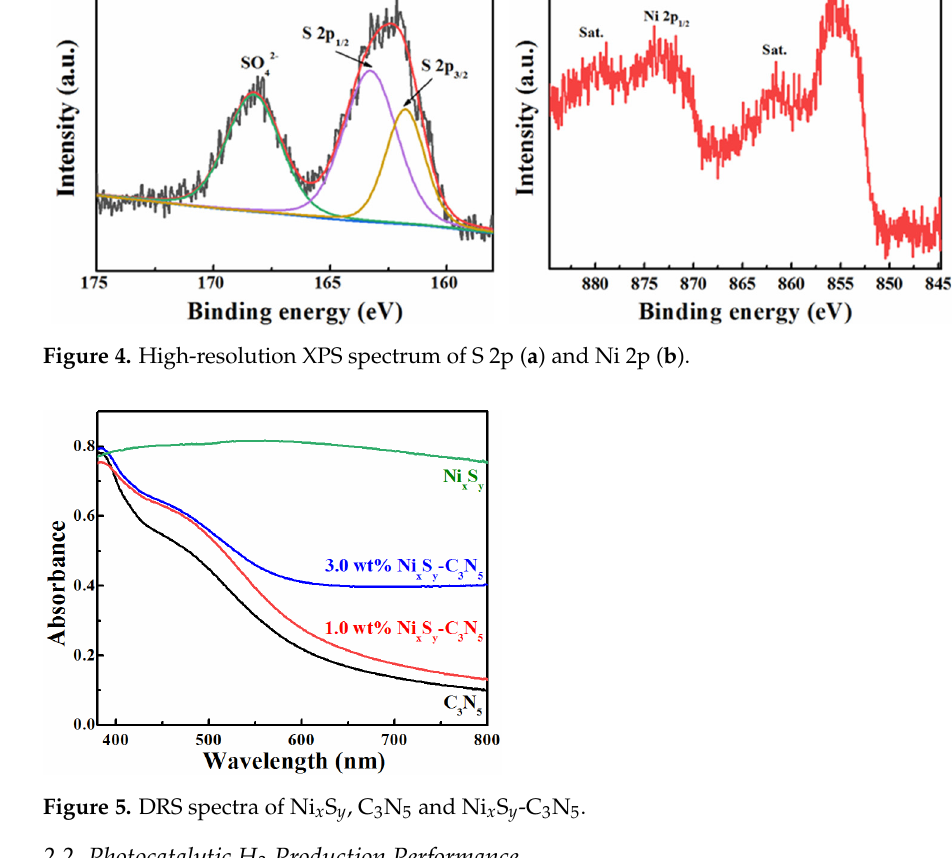
Figure 4. High-resolution XPS spectrum of S 2p ( a ) and Ni 2p ( b ).